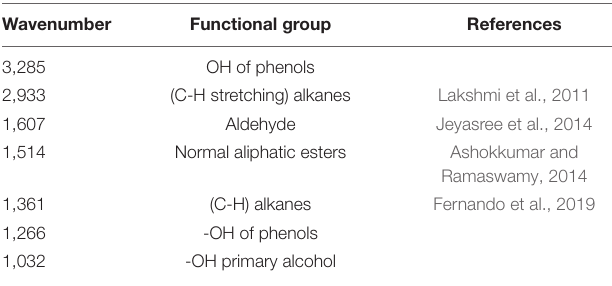
TABLE 2 | FTIR analysis of methanolic extract of O.